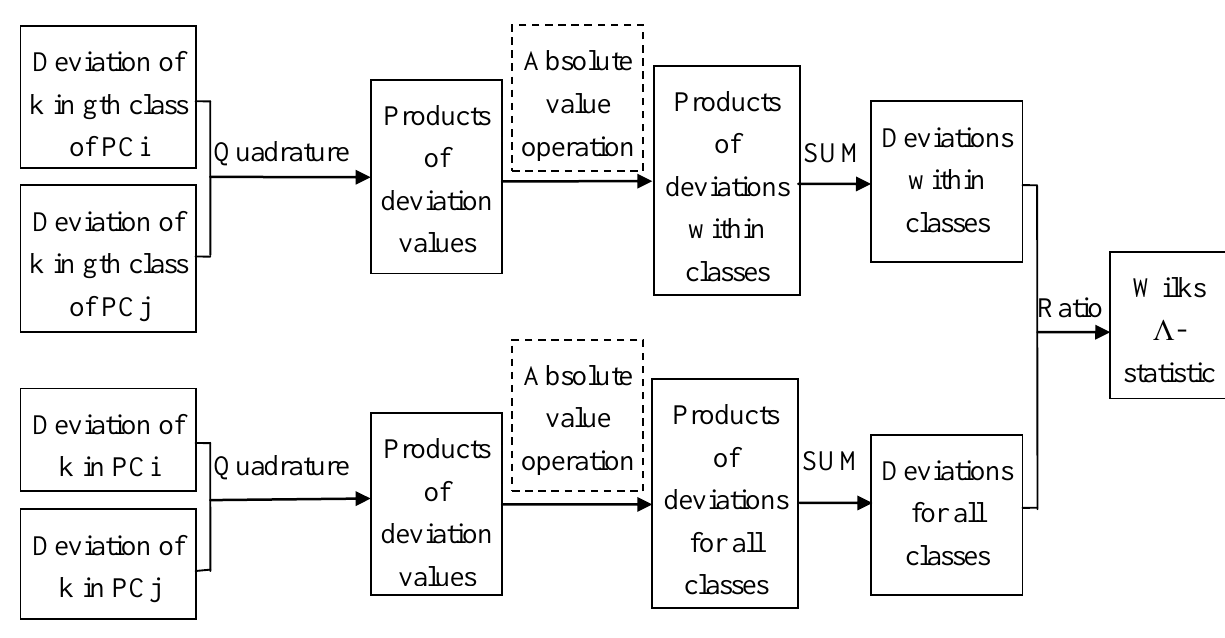
Figure 5. The flow diagram of the improved